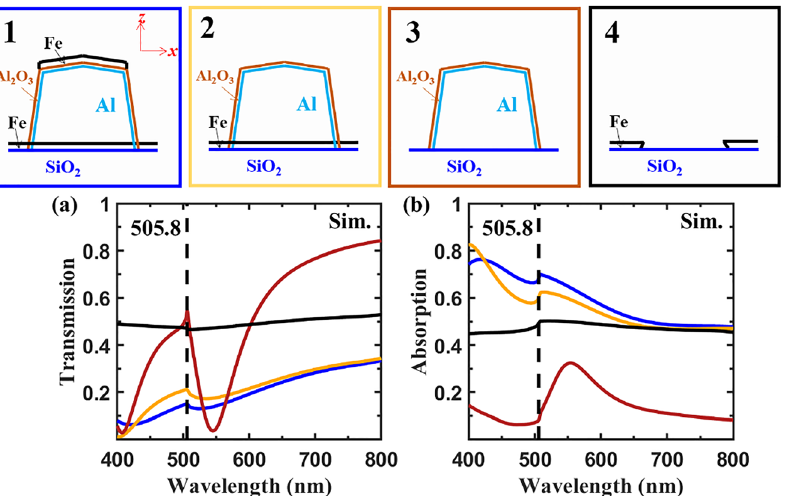
Figure S6: Calculated (a) transmission and (b) absorption spectra for the hexagonal array with a = 400 nm and n super = 1 at normal incidence ° for different simulation setups of nanostructures as depicted above in colored and numbered boxes: 1. (blue box) The currently used θ 0 = 0 setup to describe our experimental MO structure (7.5 nm Fe fi lm was deposited after the Al nanoparticle (NP) array was fabricated); 2. (orange box) Based on structure 1, the Fe material on top of Al NP is removed; 3. (brown box) Based on structure 2, the Fe material on the quartz substrate is removed; 4. (blackbox) Based on structure2, Al NP is removed, i.e. , Fe nanoholesare left. The vertical black dashed line is the in- plane diffraction wavelength as shown in Figure S5 for a = 400 nm and n super = 1 according to Eq.